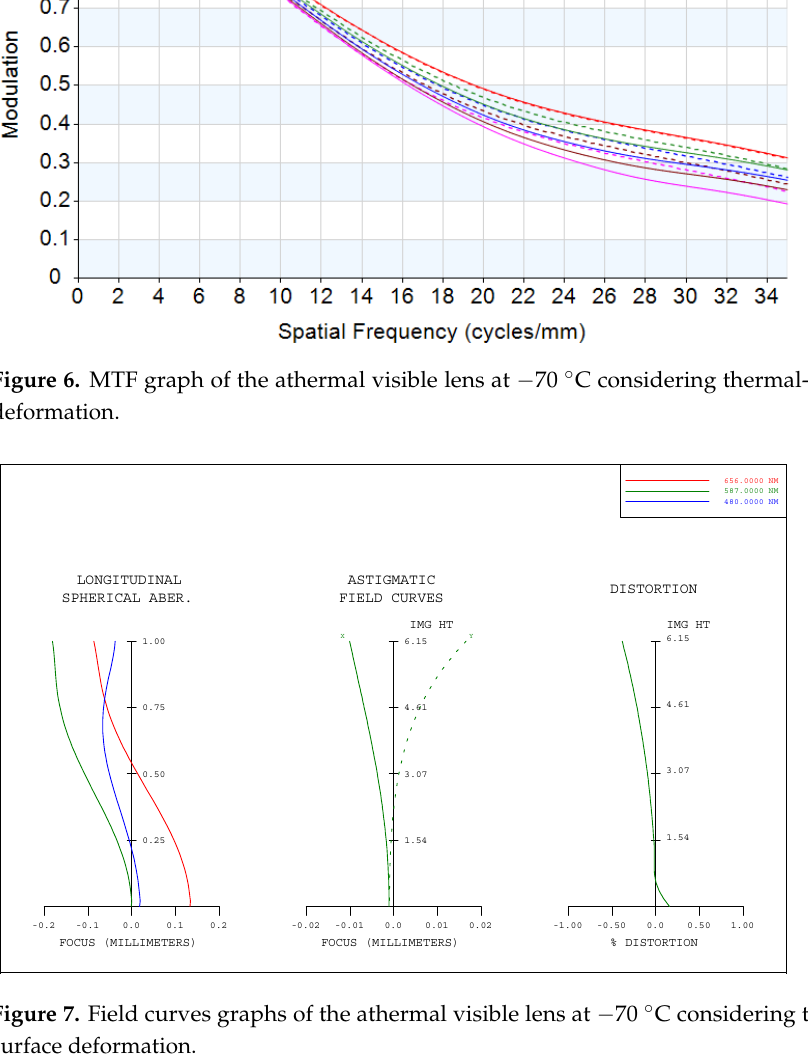
Figure 5. FEA model of the optical system.